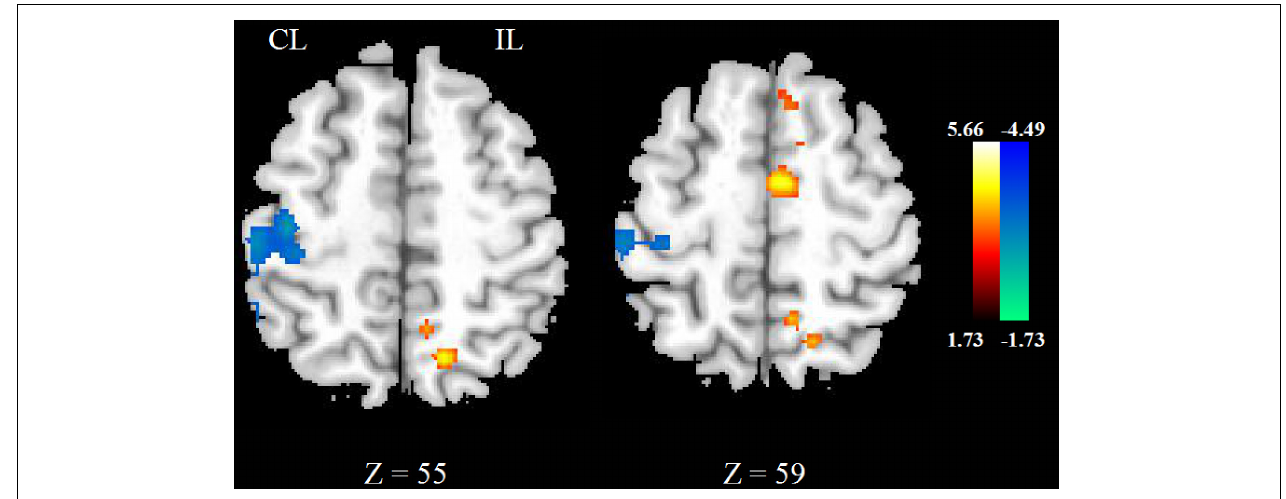
FIGURE 3 | The differences of CBF between real and sham rTMS